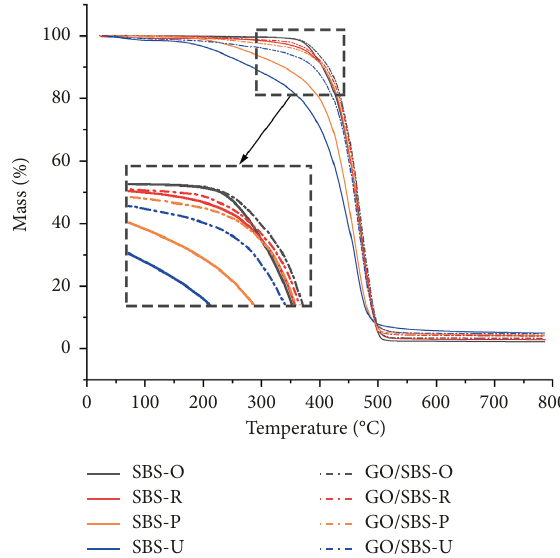
Figure 5: TG curves for SBS and the GO/SBS composite under a nitrogen atmosphere. Table 5: Indices of SBS and the GO/SBS composite for the TG test.